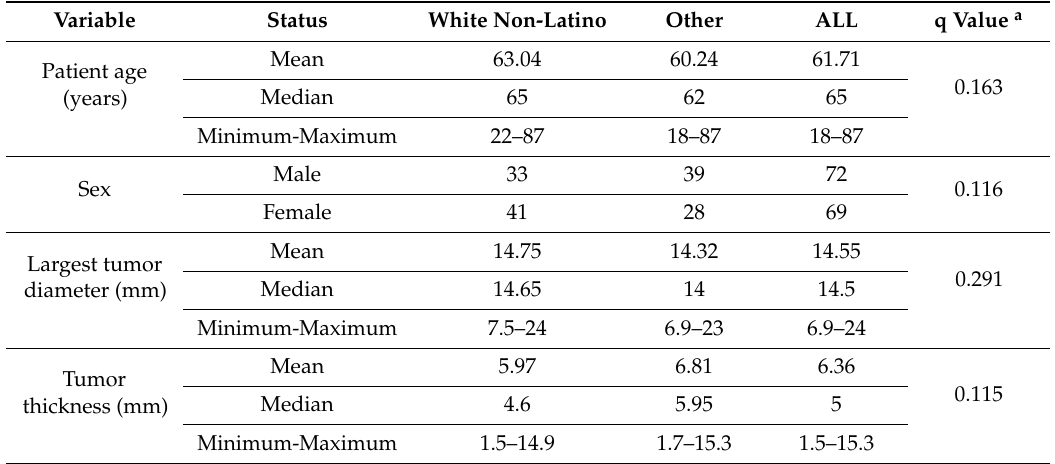
Table 1. Summary of clinical features and prognostic biomarkers in 141 patients with uveal